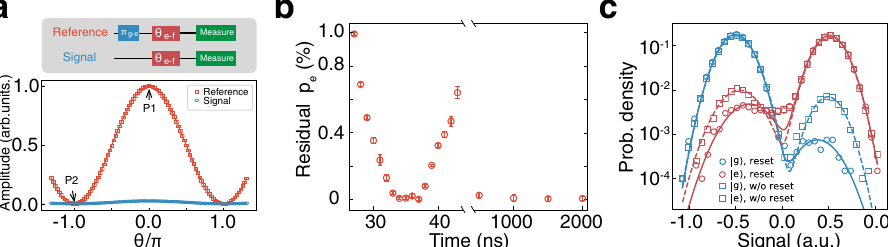
Fig. 3 Residual e j i state population measurement and improvement of the readout fi delity. a Residual e j i population measurement with Reference (red) and Signal (blue) Rabi oscillations with solid sinusoidal fi tting curves. From the fi tting, two Rabi amplitudes( A sig and A ref ) can be extracted. The Reference and Signal pulse sequences are shown in the upper left corner. P1 and P2 are two measured points in b . b e j i population measurement with different parametric reset pulse duration τ . Each data point is acquired by a "two-point method" described in the main text. At 34 ns, the population of the e j i decays to the fi rst minimum value 0.08 ± 0.08% and remains below 0.1% after 1000 ns. The error bars are statistical ( ± 1 s.d.) with 50 repetitions. c Readout fi delity enhancement with the 34 ns parametric reset pulse. The circles (squares) display the IQ analysis with (without) the 34 ns parametric pulse. Both g j i (blue) and e j i (red) are prepared and measured. When preparing the g j i state, the residual e j i state population due to the thermal excitation decreases more than one order of magnitude after applying the parametric reset pulse. The readout fi delity consequently improves from 96.13% to 99.43% for g j i and 92.69% to 96.05% for e j i